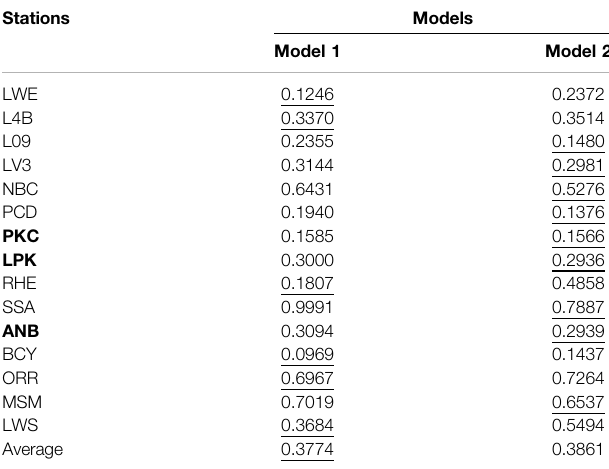
TABLE 6 | The average errors computed at each station: the underlined values display the minimum error values. The bold characters indicate that there is little difference between the results of the two